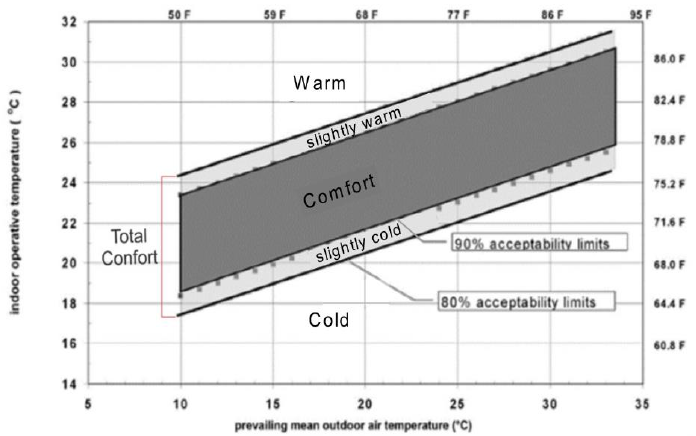
Figure A9. Adaptative Thermal Comfort limits ASHRAE 55-2017 ( own preparation based on the ASHRAE 55-2017 model).